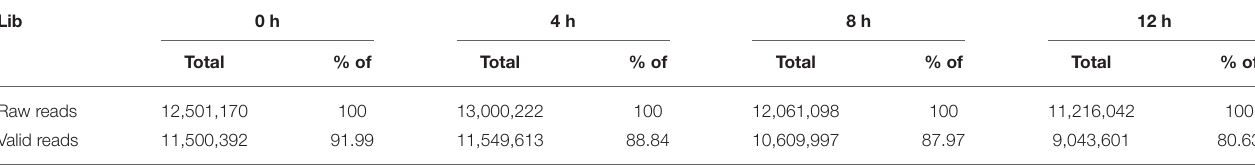
TABLE 2 | Statistics of transcriptomic small RNA reads. Lib